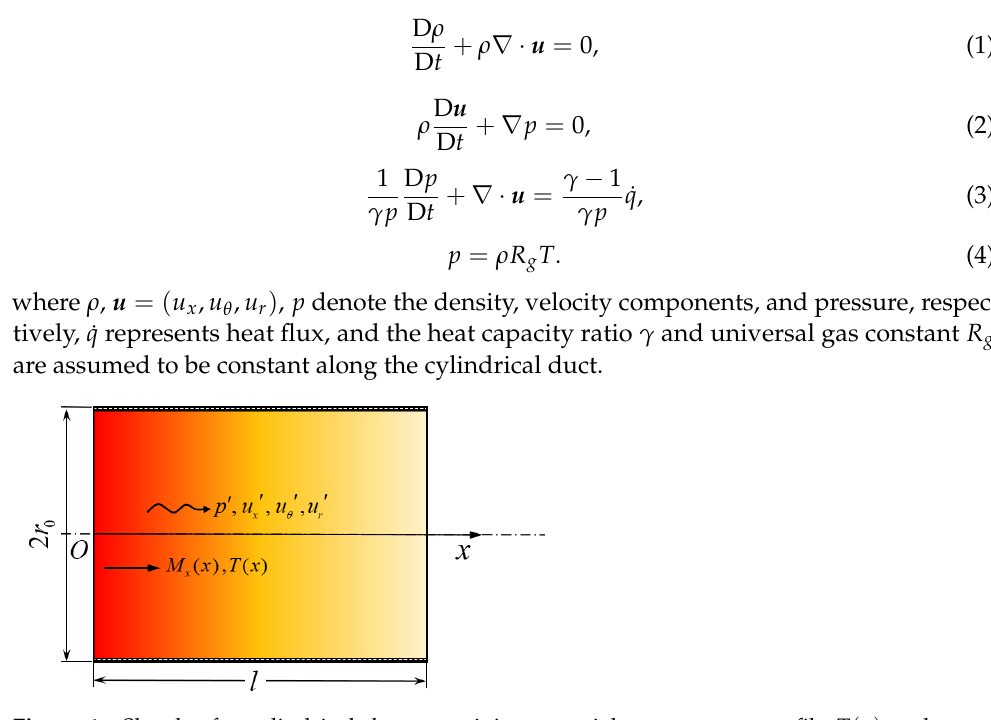
Figure 1. Sketch of a cylindrical duct containing an axial temperature profile T ( x ) and mean flow M x ( x )